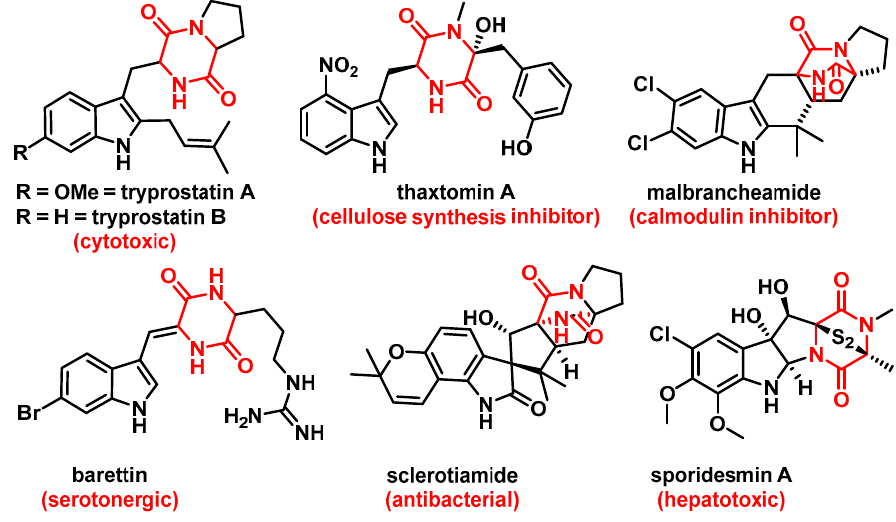
Figure 1. Representative bioactive indole diketopiperazines with diverse activities.